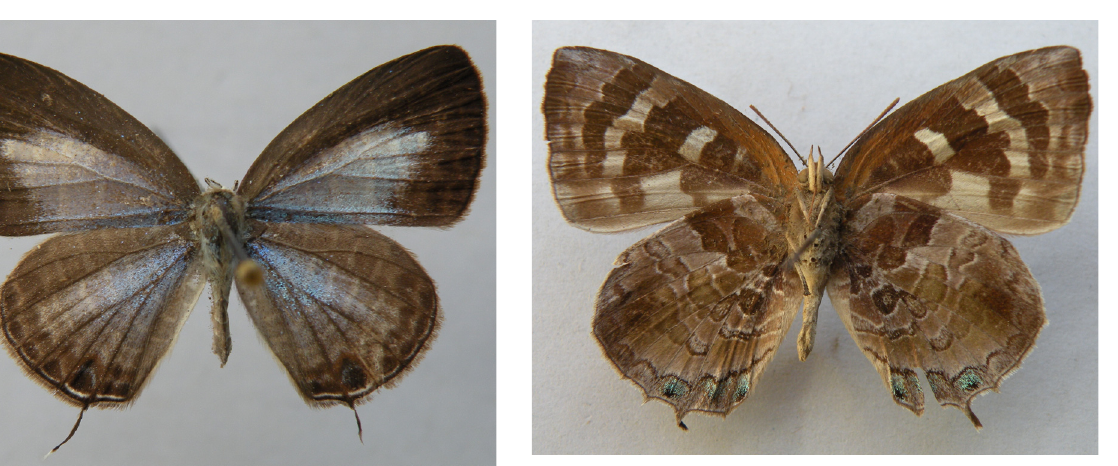
Image 3. Transparent Six-line Blue Nacaduba kurava